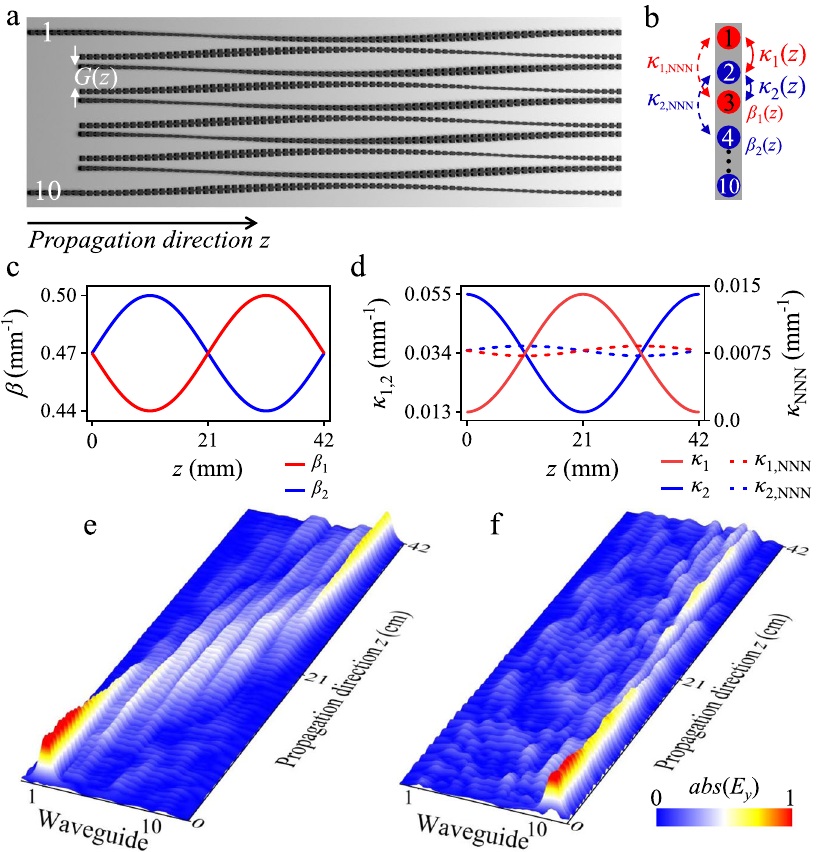
Fig. 1 Asymmetric topological pumping in an array of SPPs waveguides. a Schematic illustration of the photonic Rice-Mele model consisting of periodically bending waveguides, with sinusoidal modulations of the nearest-neighbor (NN) waveguide spacing G z G ( z ) and height parameters of the “ H-shaped ” unit along the propagation direction z . b Illustration of the extended Rice-Mele model with staggered on-site potentials (propagation constants β κ κ 1,2 ), NN coupling strengths ( 1,2 ), and next-nearest-neighbor coupling strength ( NNN ). The detailed values of the sinusoidally modulated ( c ) propagating constants and ( d ) coupling strengths κ NN and κ NNN along the propagation direction z . Experimental data for the near- fi eld measurements of the electric fi eld ( E y , perpendicular to the array surface) after injecting 17 GHz microwaves from e left boundary (the 1st waveguide) and f right boundary (the 10th waveguide),